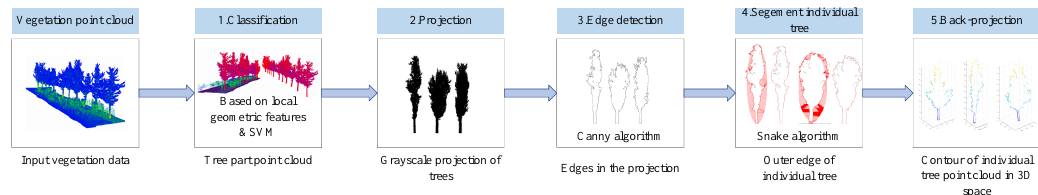
Figure 1. Flowchart of the proposed point cloud individual tree segmentation method.